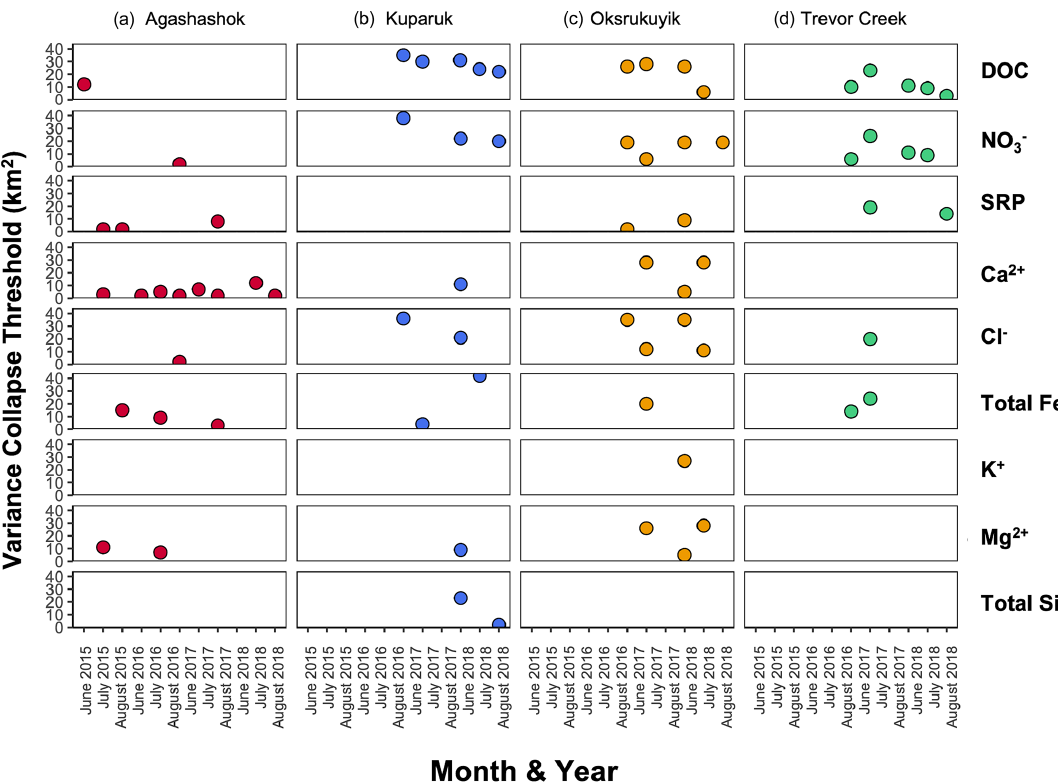
Figure 8. Scatter plot of variance collapse threshold for each repeated sampling for the (a) Agashashok River, (b) Kuparuk River, (c) Ok- srukuyik Creek, and (d) Trevor Creek watersheds for select reactive (e.g., DOC, NO 3 − , and SRP) and conservative solutes (Ca 2 + , Cl − , Fe (total for NPS/USGS; nominally dissolved for TFS), K + , Mg 2 + , and total Si). When data were not present, there was no significant collapse detected. Variance collapse thresholds are not shown for the Akillik and Cutler rivers, as these thresholds were often